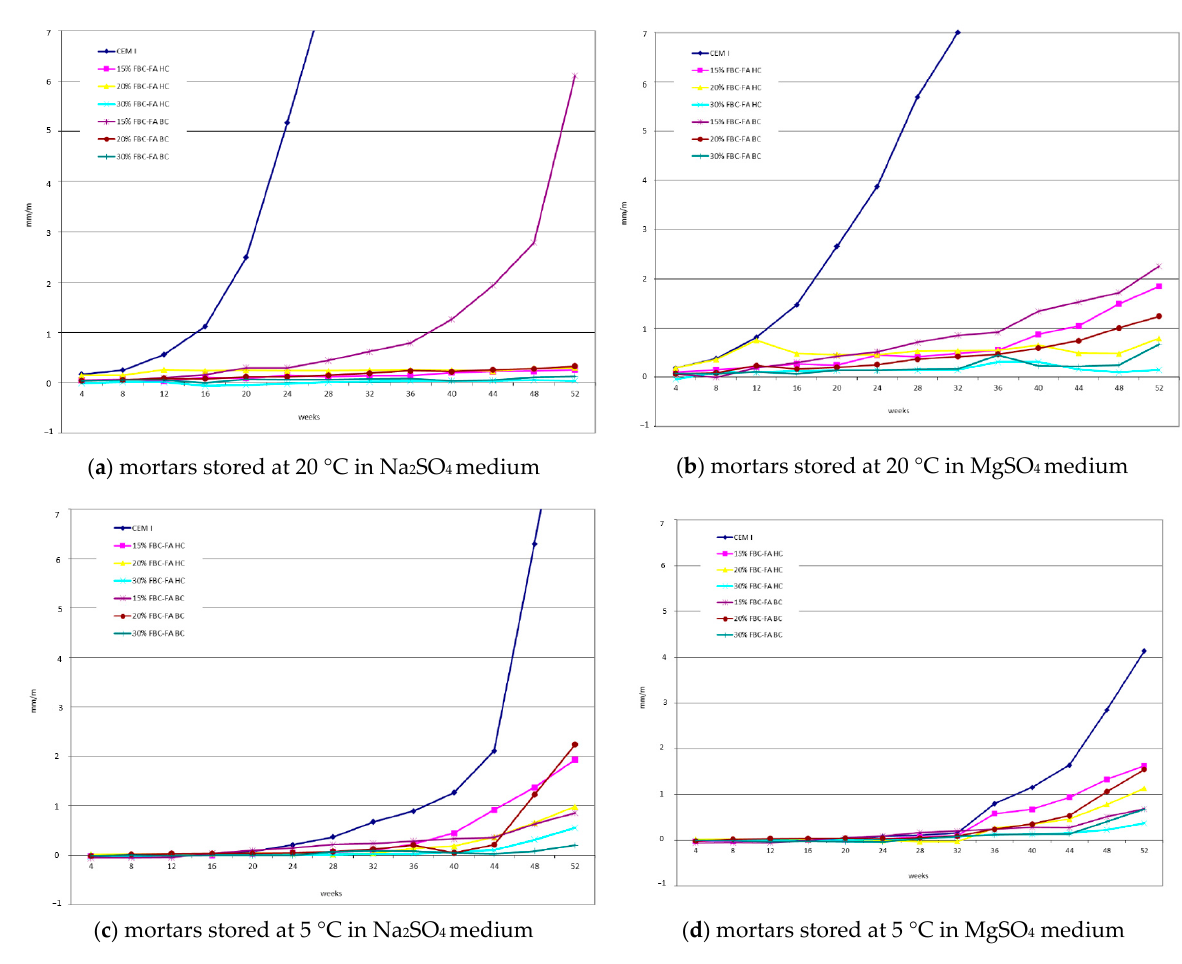
Figure 3. Relative linear changes of ash-cement binder mortars with AFBC fly ash from hard (FBC FA HC) and brown (FBC FA BC) coal combustion. 3.3. Sulfate Corrosion Resistance of Blended Fly Ash-Cement Binders—SEM–EDS and visual changes. The pictures of FBC fly ash-cement mortar samples morphology are shown in Figures 4 and 5.